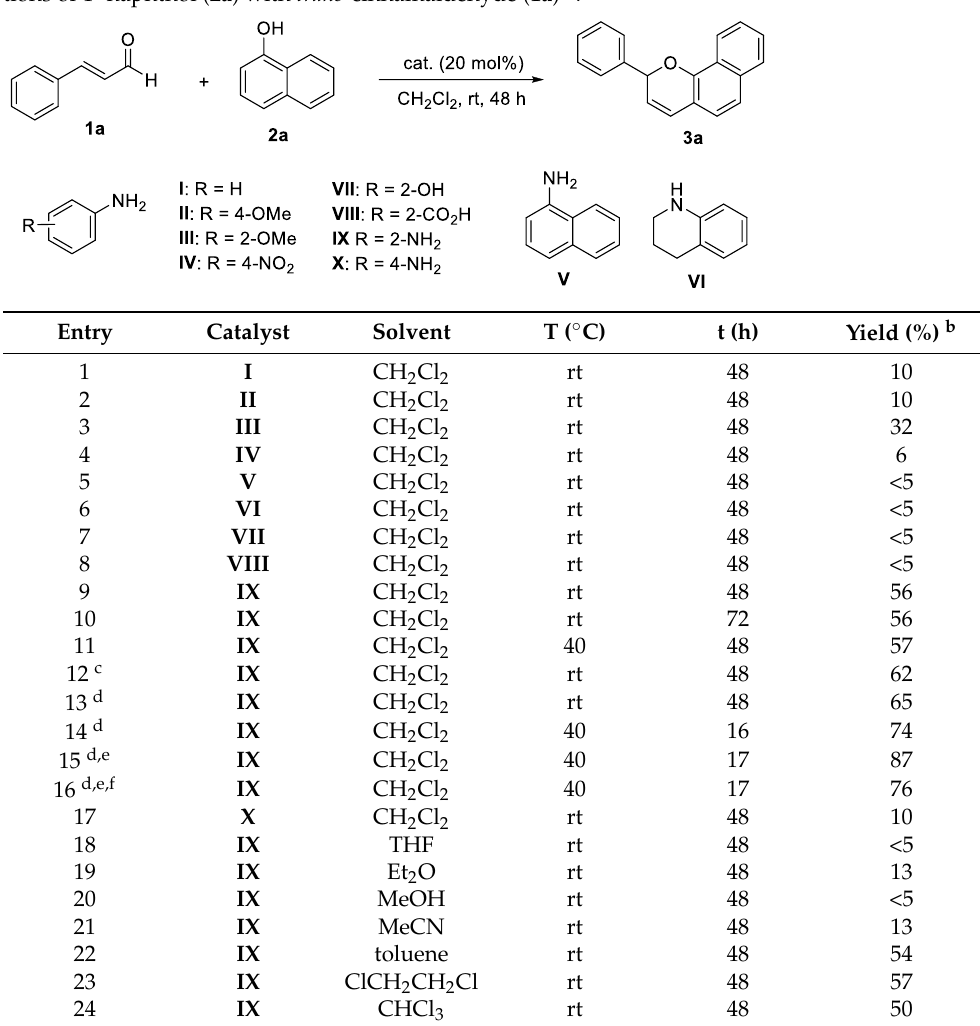
Table 1. Exploration and optimization of the aniline-catalyzed Mannich–Diels–Alder cascade reac- tions of 1- naphthol ( 2a ) with trans -cinnamaldehyde ( 1a ) a .